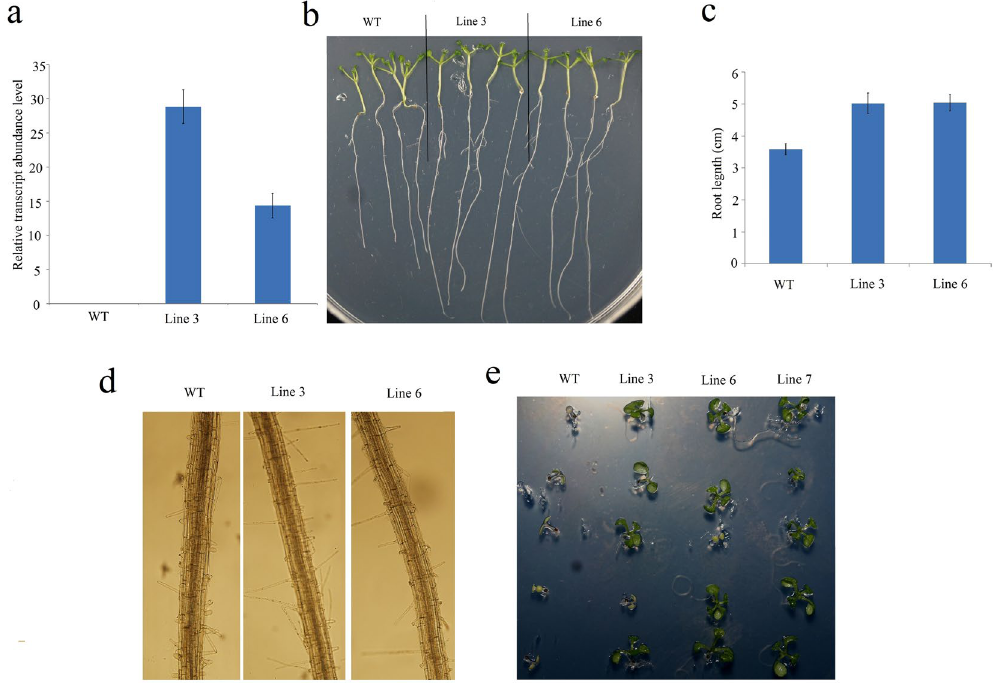
Figure 7. (a) Relative expression of PheWRKY72 in transgenic lines. The expression of internal control gene ( β -tubuli) was arbitrarily set at 1.0. (b ) Response of 35S-PheWRKY72-2 Arabidopsis transgenic lines to drought stress (10% PEG). (v) The primary root lengths of WT and transgenic seedlings under drought stress (10% PEG). (d) Observation of root hairs under drought stress (10% PEG). (e ) Response of the 35S-PheWRKY72-2 Arabidopsis transgenic lines to drought stress (20%